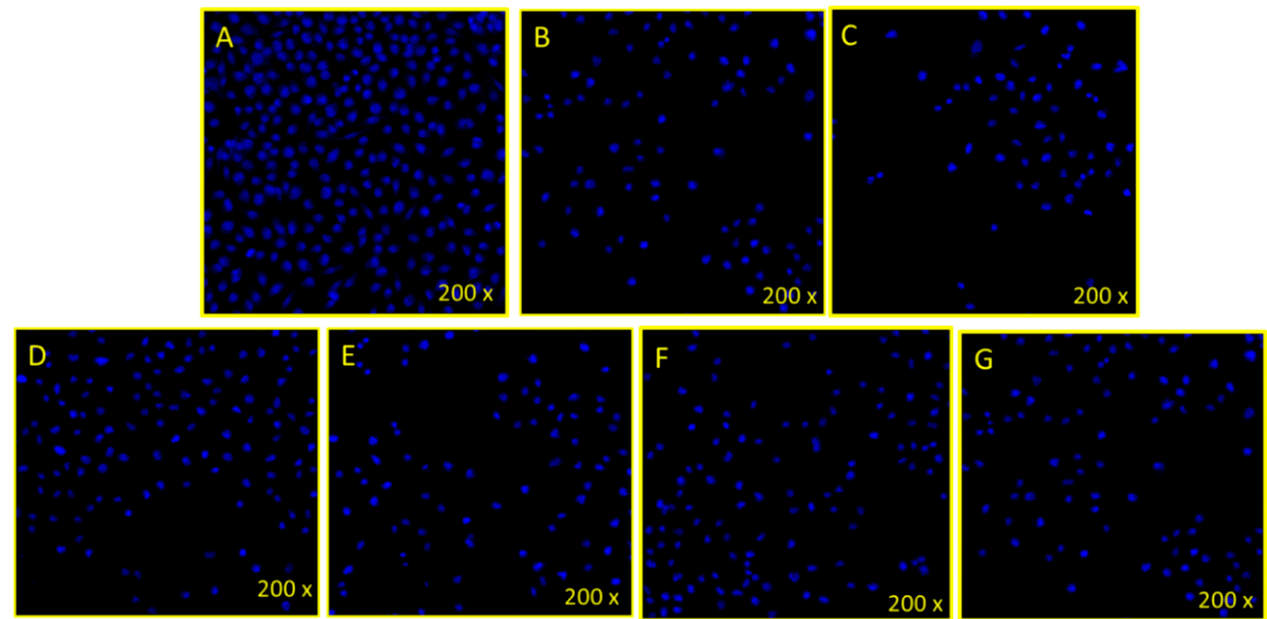
Figure 5. Cancer cell death via treatment of Co 0.5 Ni 0.5 Ga x Fe 2 − x O 4 MCs: shows the impact of Co 0.5 Ni 0.5 Ga x Fe 2 − x O 4 (0.0 ≤ x ≤ 1.0) MCs on cervical (HeLa) cancer cells stained with DAPI post 72 h treatment. Figure ( A ): control (without MCs treatment), ( B ): (0.0), ( C ): (0.02), ( D ): (0.04), ( E ): (0.06), ( F ): (0.08), and ( G ): (0.01).